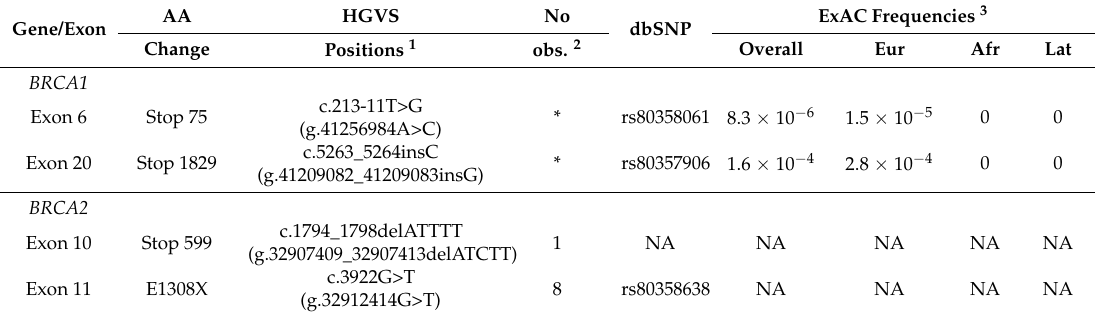
Table 1. BRCA1 and BRCA2 pathogenic variants detected in Puerto Rican breast cancer patients.